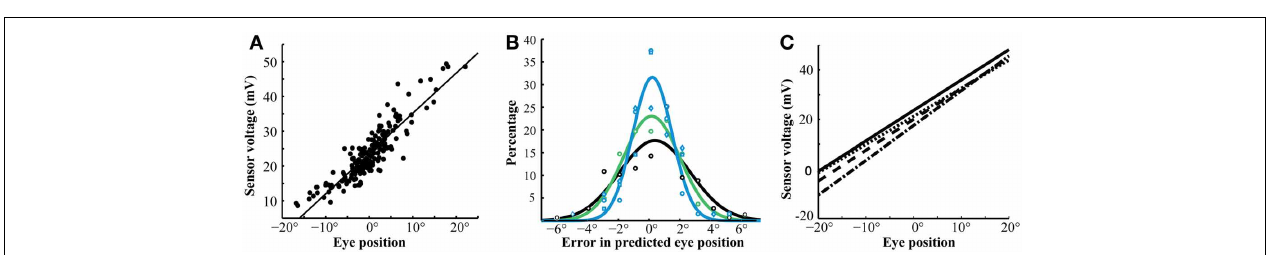
under 1 ◦ in 47% of instances. Reliability of the predictions did not vary dramatically between sessions and only slightly between birds. The lines represent Gaussian fits for each bird. (C) Linear fits of eye position and magnetic sensor voltage from the same bird during four sessions. The relationship was stable throughout this 5-day period. Slopes: 1.228 (solid), 1.151 (dashed), 1.245 (dotted), 1.404 (dot-dash). Y-intercepts: 23.63 (solid), 21.52 (dashed), 20.04 (dotted), 17.56